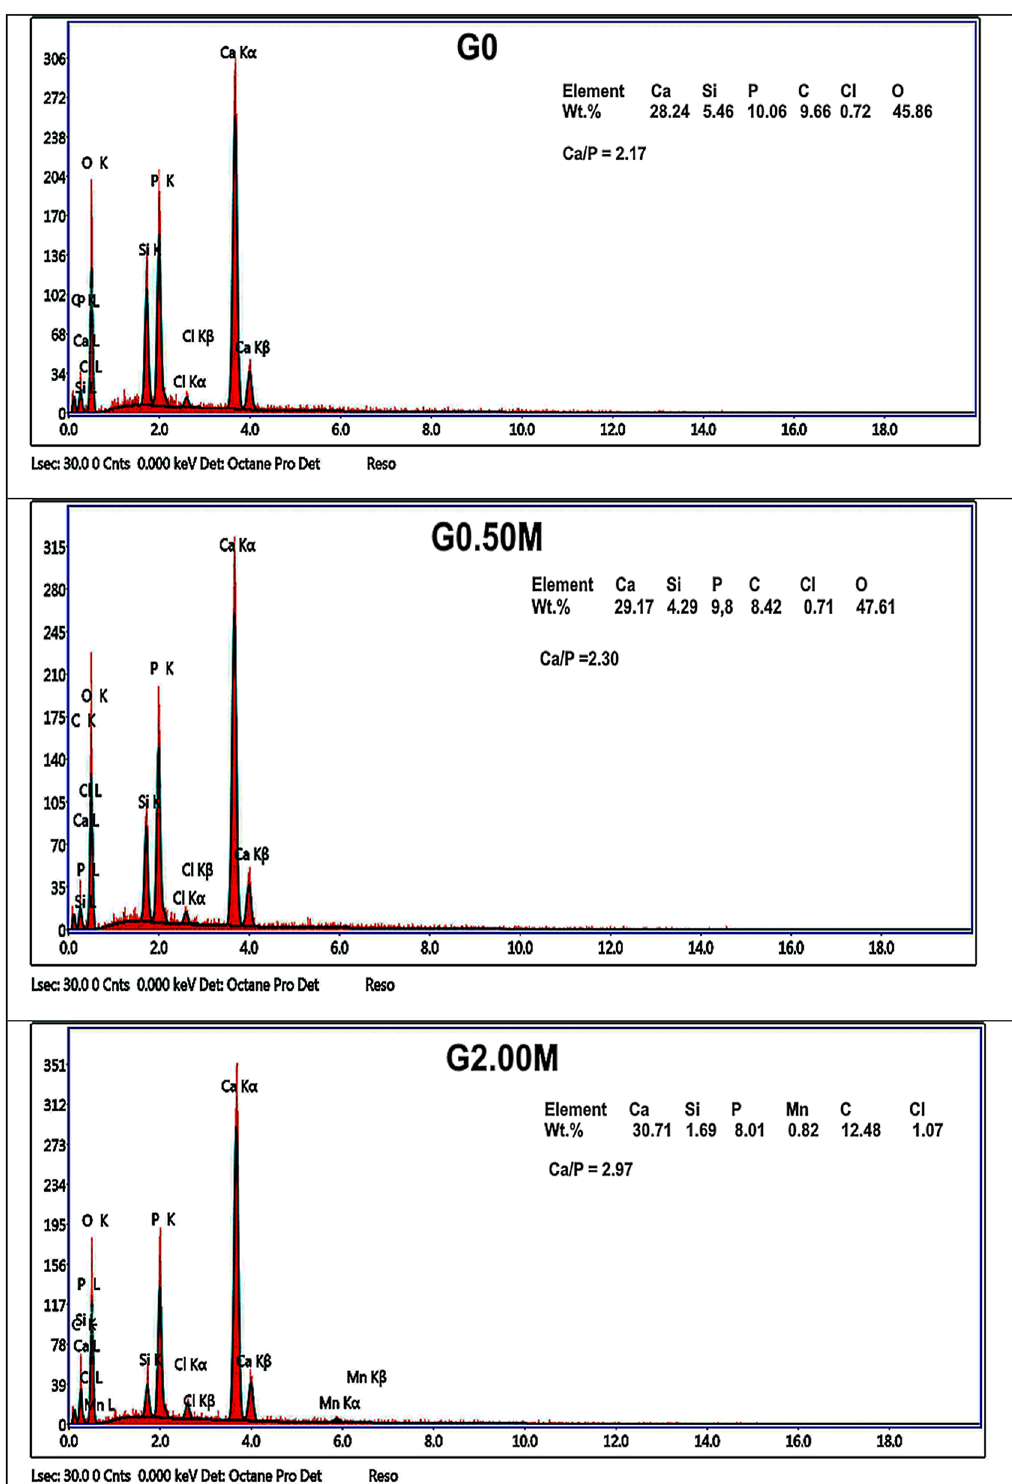
Figure 9: EDX microanalysis of G0, G0.50M and G2.00M glasses sintered at 1,100°C/2 h and soaked in SBF for a